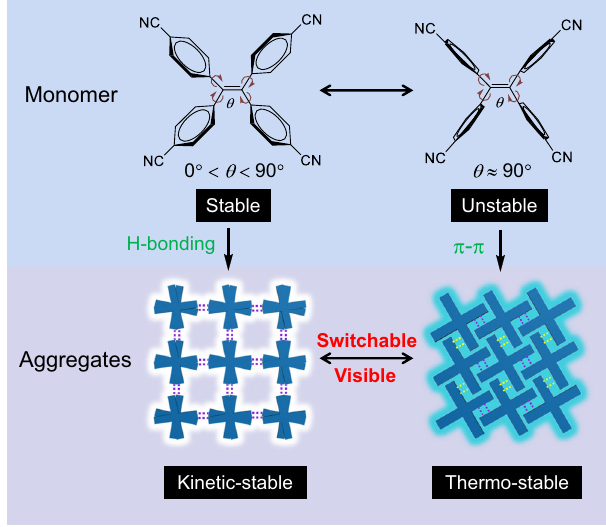
Fig. 1 Tunable emission based on dynamic intermolecular interactions in switchable HOFs. The purple and yellow dashed lines indicate hydrogen bonding and π – π interactions, respectively. ‘ θ ’ indicates the dihedral angles between four phenyl groups and the central ethenyl